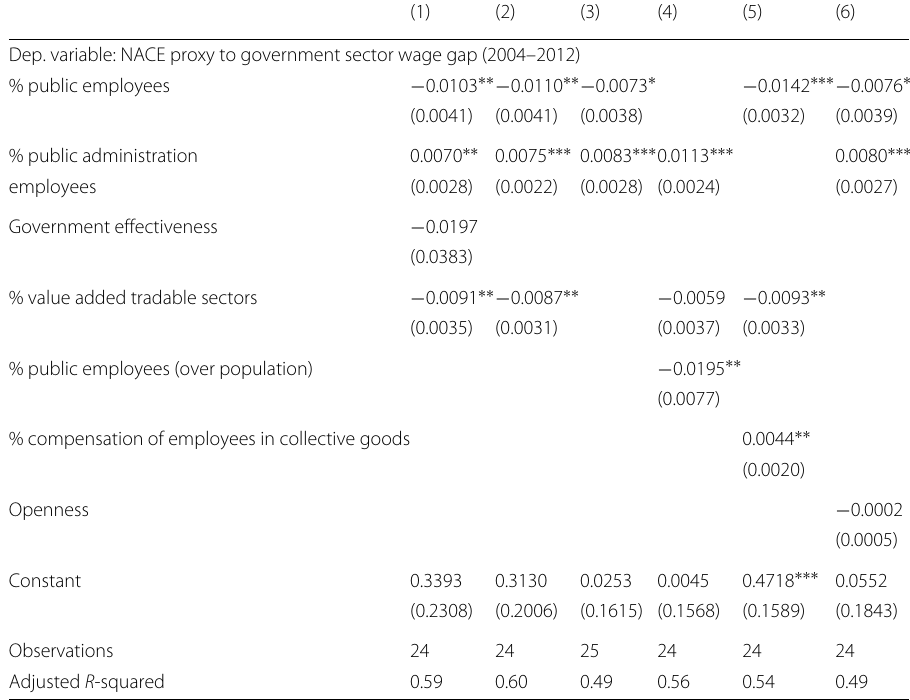
Table 2 Determinants of the public sector pay gap: government monopolistic power (1) (2) (3) (4) (5) (6) Dep. variable: NACE proxy to government sector wage gap